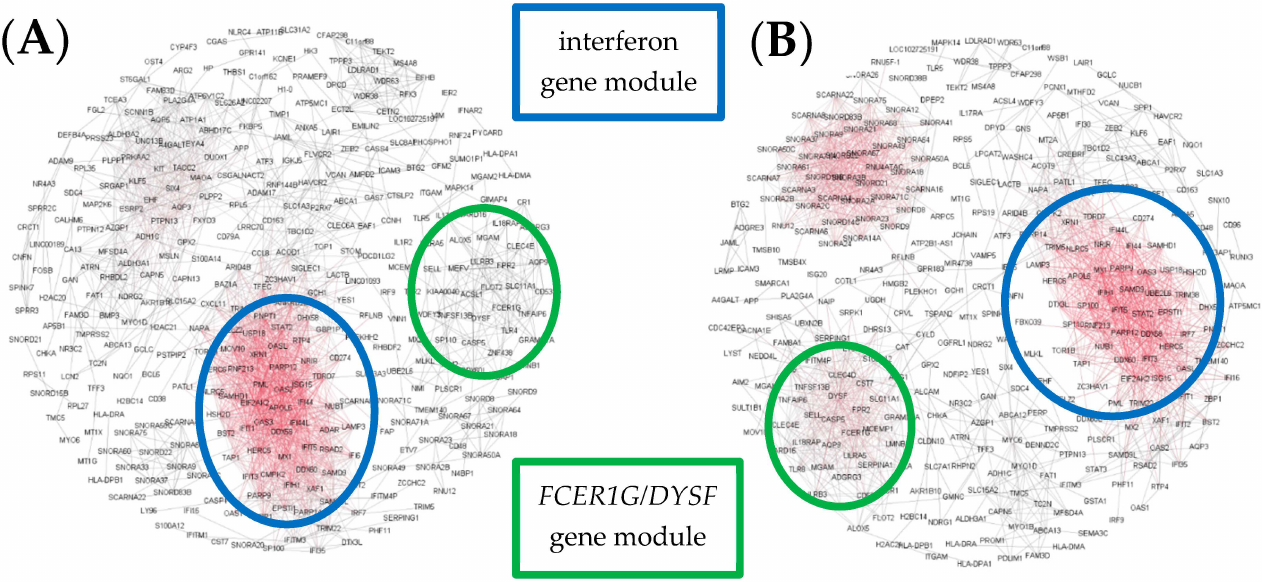
Figure 7. Illustrative examples of personal gene network structures generated in Gephi for representative subjects from Cluster D. Examples ( A , B ) show networks with more than two prominent modules. Red indicates highly connected genes (“hubs”) and black denotes genes with few